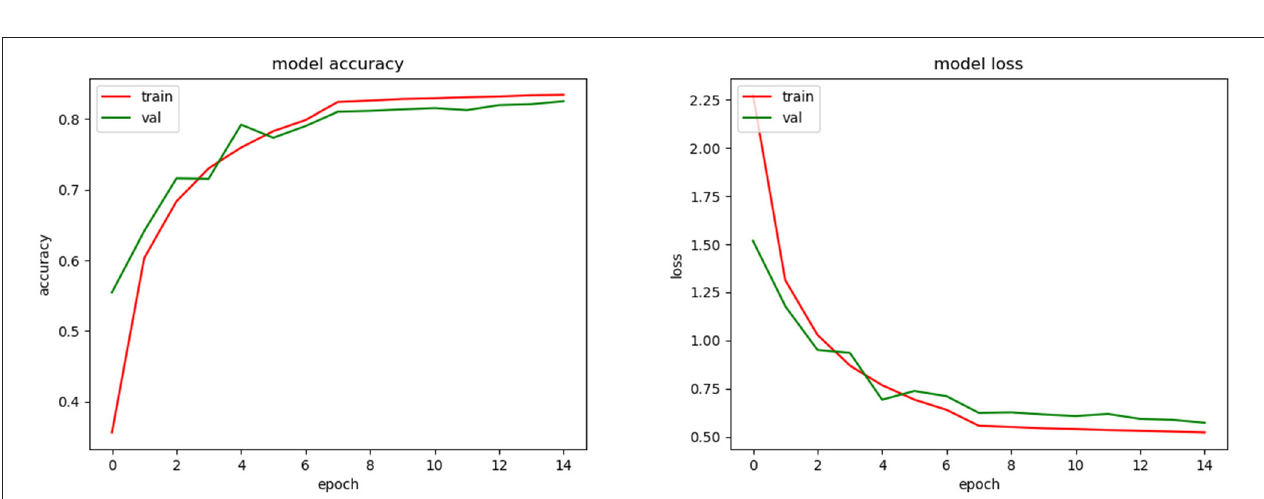
FIGURE 10 | Training accuracy and loss for CNN model with FSD-M dataset and (possibly) SSPB bias.